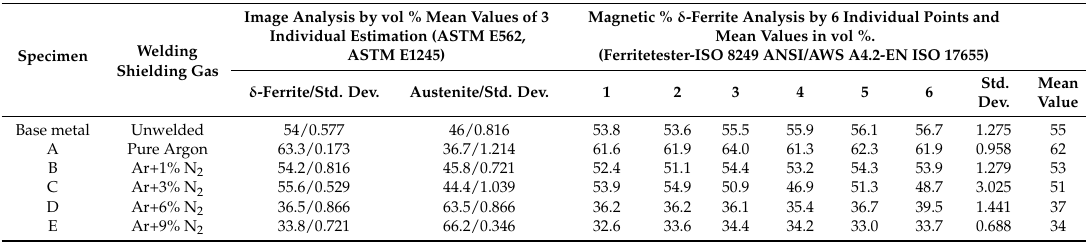
Table 4. Magnetic and microstructural phase analysis results of base metal and five weldments.